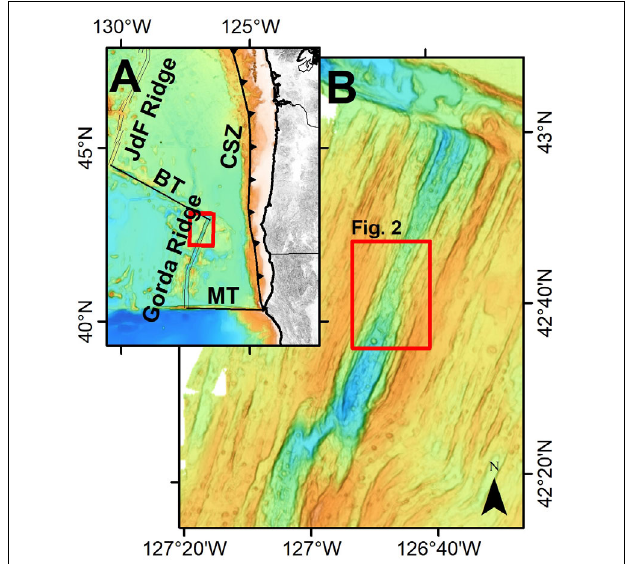
FIGURE 1 | (A) Regional map showing the location of North Gorda Segment of the Gorda mid-ocean ridge spreading center. BT is Blanco Transform, MT is Mendocino Transform, and CSZ is Cascade Subduction Zone. Depth ranges from –5000 (deep blue) to 0 m (white) and red box shows extent of part B. (B) Ship bathymetry of North Gorda segment. Red box encompasses central part of segment where high-resolution AUV bathymetric surveys shown in Figure 2 were collected. Depth range is from –4500 m (blue) to –1500 m (orange).